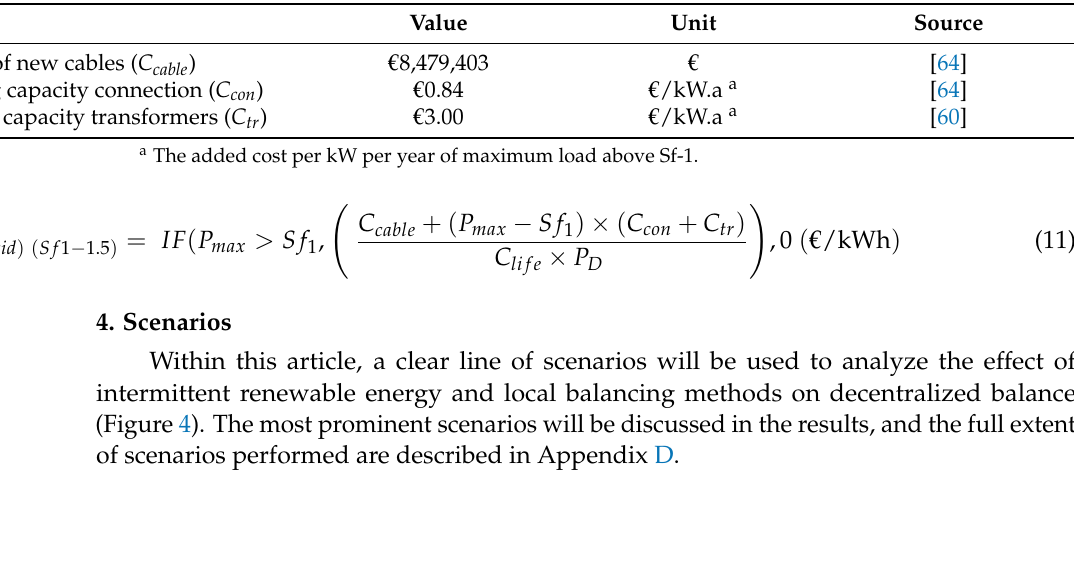
Table 4. The average cost of grid